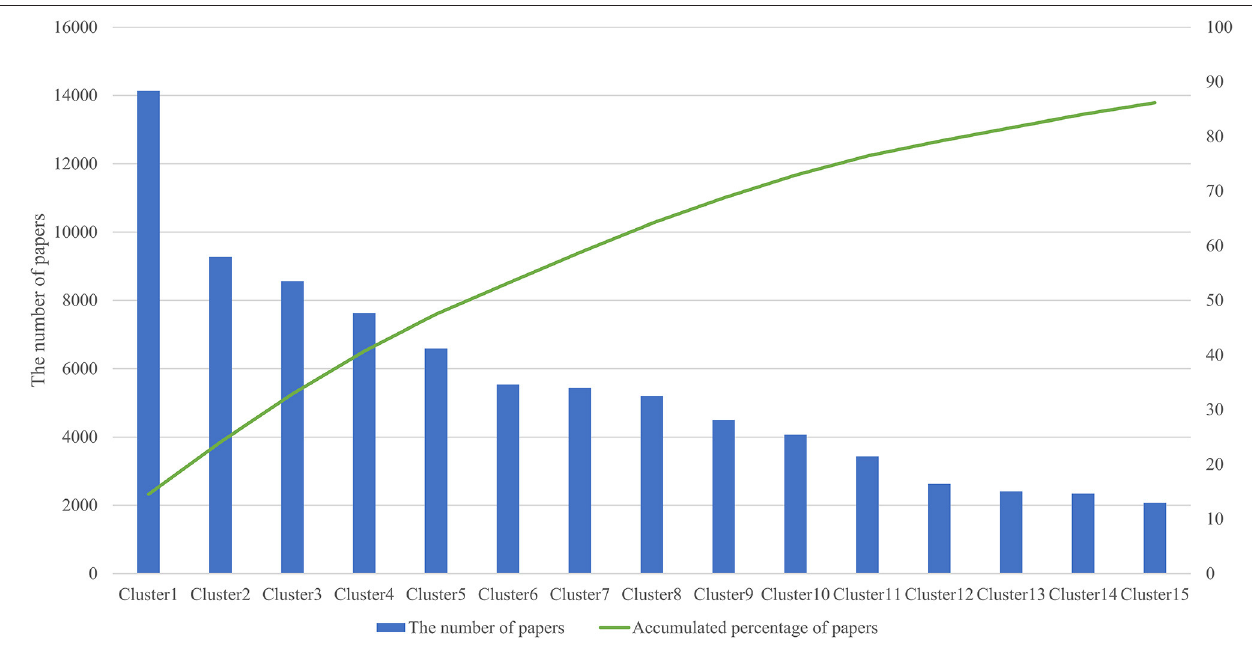
FIGURE 2 | Top 15 cluster size and accumulated